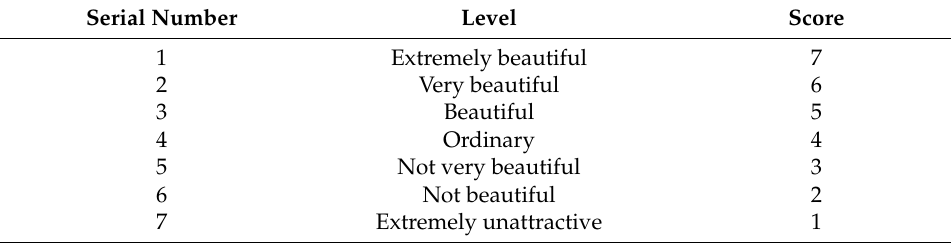
Table 5. Evaluation criteria of landscape